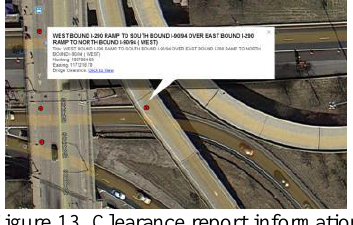
Table 2. Ranges for minimum vertical clearance (2011, A Policy